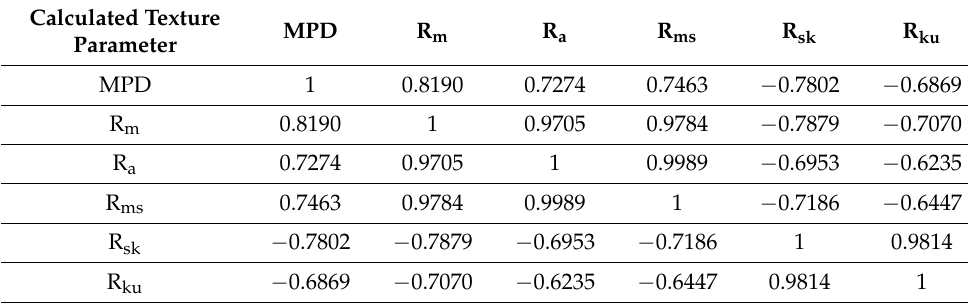
Table 7. Correlation coefficients between calculated texture parameters.